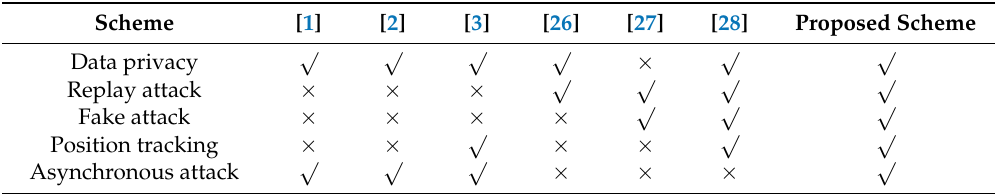
Table 2. Security comparisons with other